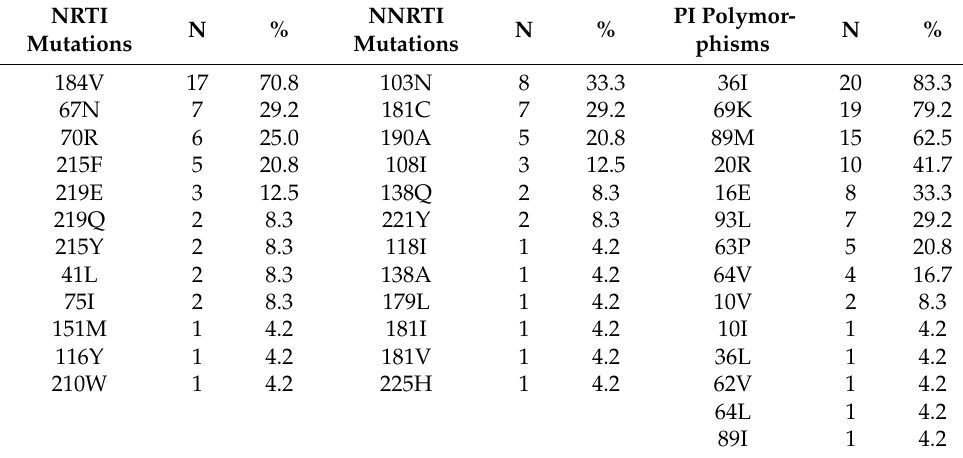
Table 3. Prevalence of resistance mutations or natural polymorphisms scored as related to resistance in reverse transcriptase and protease regions among cART-experience patients. Only the last sample was counted if more than one sample was available. NRTI = nucleoside reverse transcriptase inhibitor; NNRTI = non-nucleoside reverse transcriptase inhibitor; PI = Protease